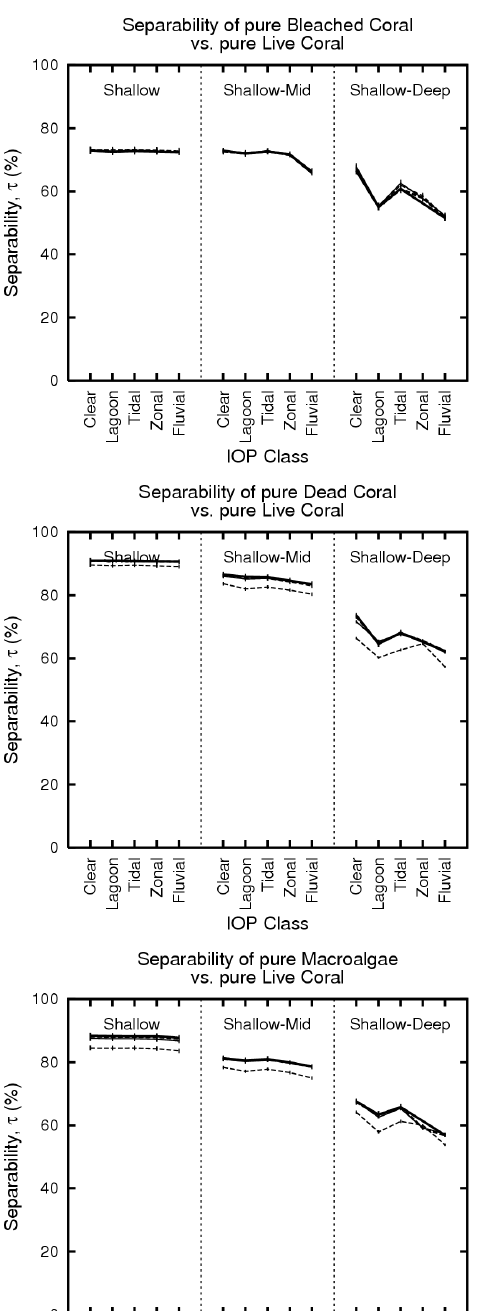
Figure 9. Depth-variable results for separability of Bleached Coral, Dead Coral and Macroalgae from Live Coral for pure cover proportions (left column) and for 0.2 proportion (20%) in Live Coral (right column). Results are for depth variation scenarios Shallow (0.5, 2 m), Shallow-Mid (0.5, 2, 5 m) and Shallow-Deep (0.5, 2, 5, 10, 20 m) combined with all IOP classes. Wind speed is 2 ms − 1 , dotted and solid lines show sensor SNR 400:1 and 800:1. Error bars are  1S.E across the ten repeat